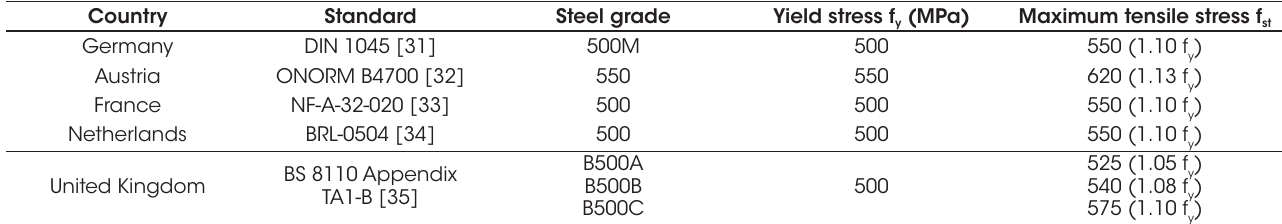
and f values for steel grade identical to CA 50 y st